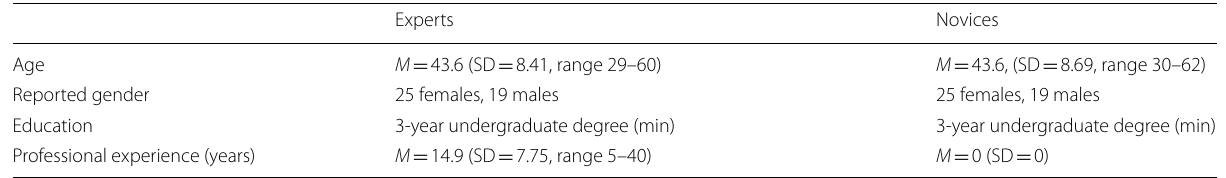
Table 1 Demographic details of the expert and novice participants